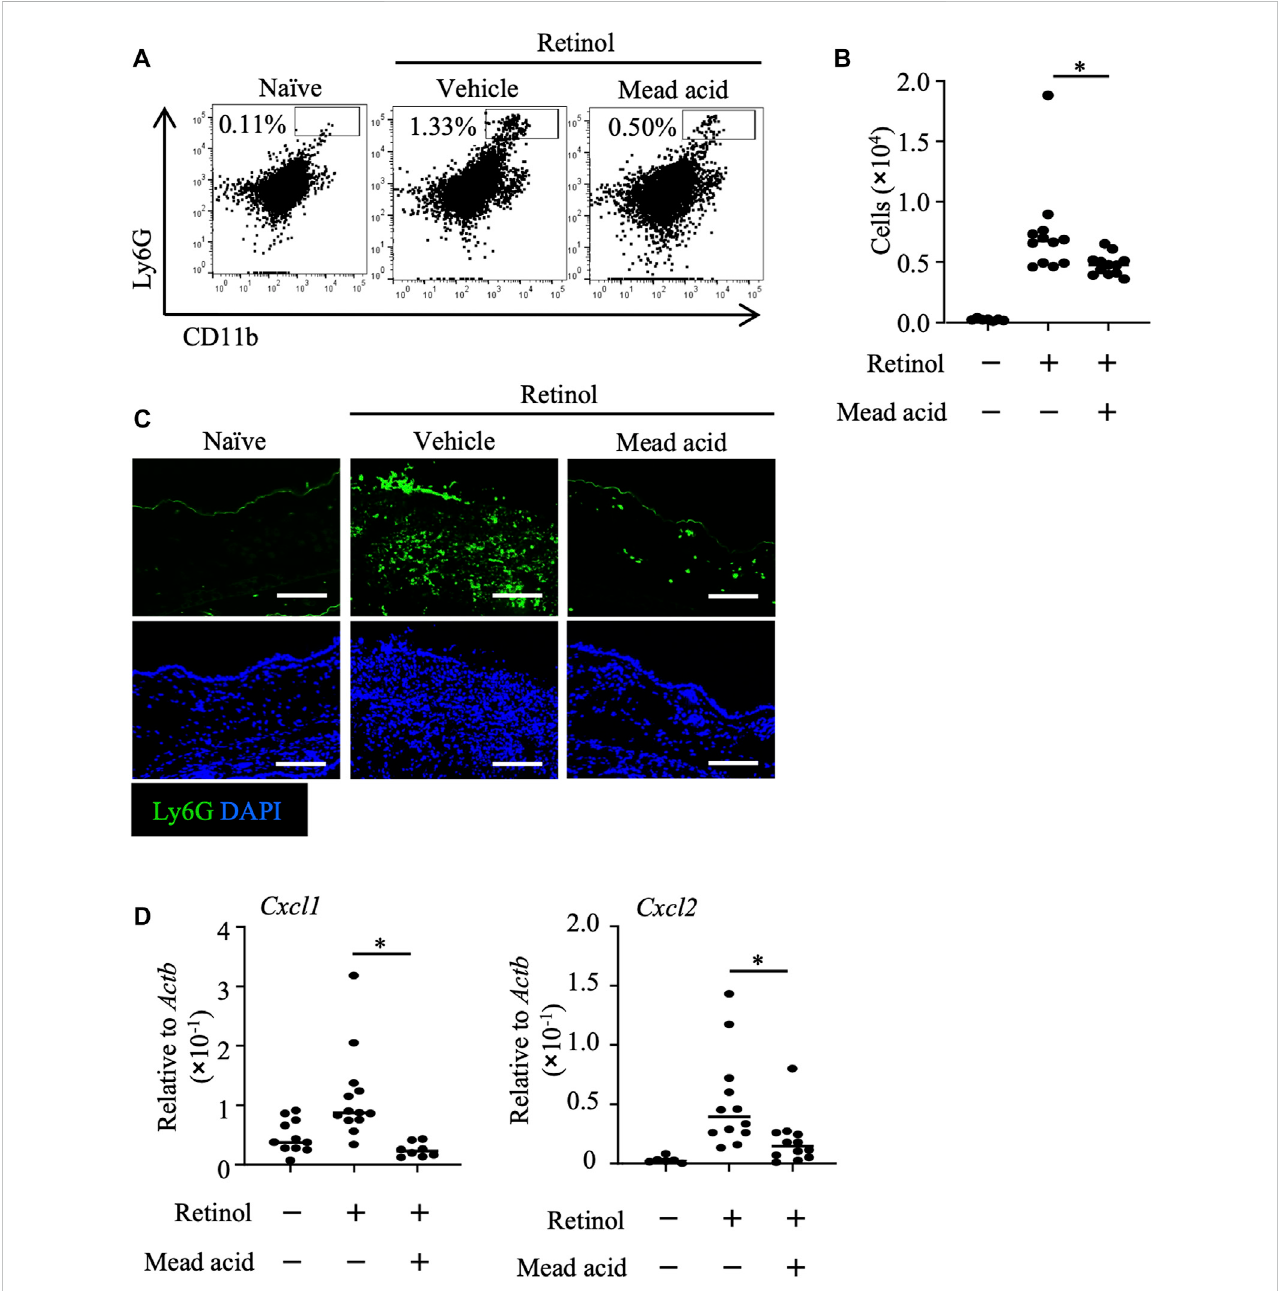
FIGURE 2 Mead acid inhibits neutrophil in fi ltration in retinol-induced irritant contact dermatitis (ICD). ICD was induced by topical application of retinol for 4 consecutive days. Mice were treated topically with vehicle or mead acid after each retinol treatment. (A) Cells were isolated from murine ears and used for fl ow cytometric analysis. Numbers indicate the percentages of Ly6G + CD11b + neutrophils. Representative images are shown. (B) The number of Ly6G + CD11b + neutrophils was determined on the basis of total cell numbers and fl ow cytometric data. (C) Frozen ear sections obtained on day 4 were stained with the indicated antibodies for immunohistologic analysis. Representative images from two independent experiments are shown. Bars, 100 μ m. (D) Ear tissues were homogenized to isolate mRNA, and Cxcl1 and Cxcl2 expression was measured by quantitative RT-PCR analysis and normalized to that of Actb . Data are combined from four independent experiments. Horizontal bars indicate median values. * p <